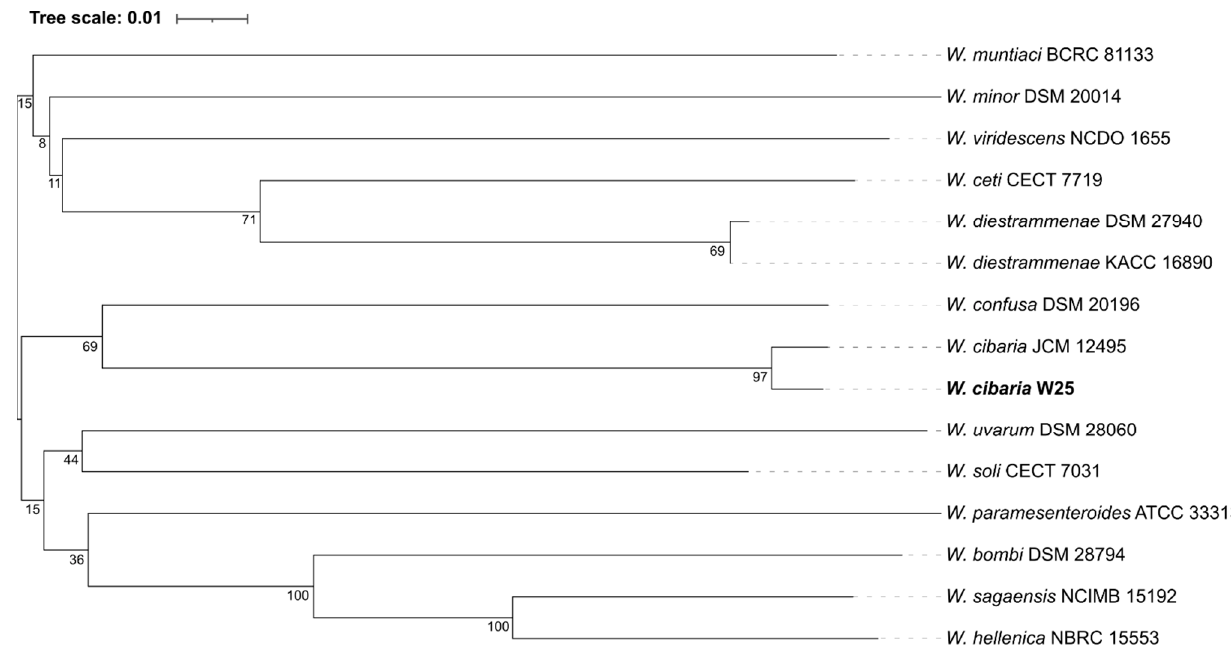
Figure 1. Tree inferred with FastME 2.1.6.1 [29] from GBDP distances calculated from genome sequences. The branch lengths are scaled in terms of GBDP distance formula d 5 . The numbers above branches are GBDP pseudo-bootstrap support values >60% from 100 replications, with an average branch support of 55.9%. The tree was rooted at the midpoint [30].